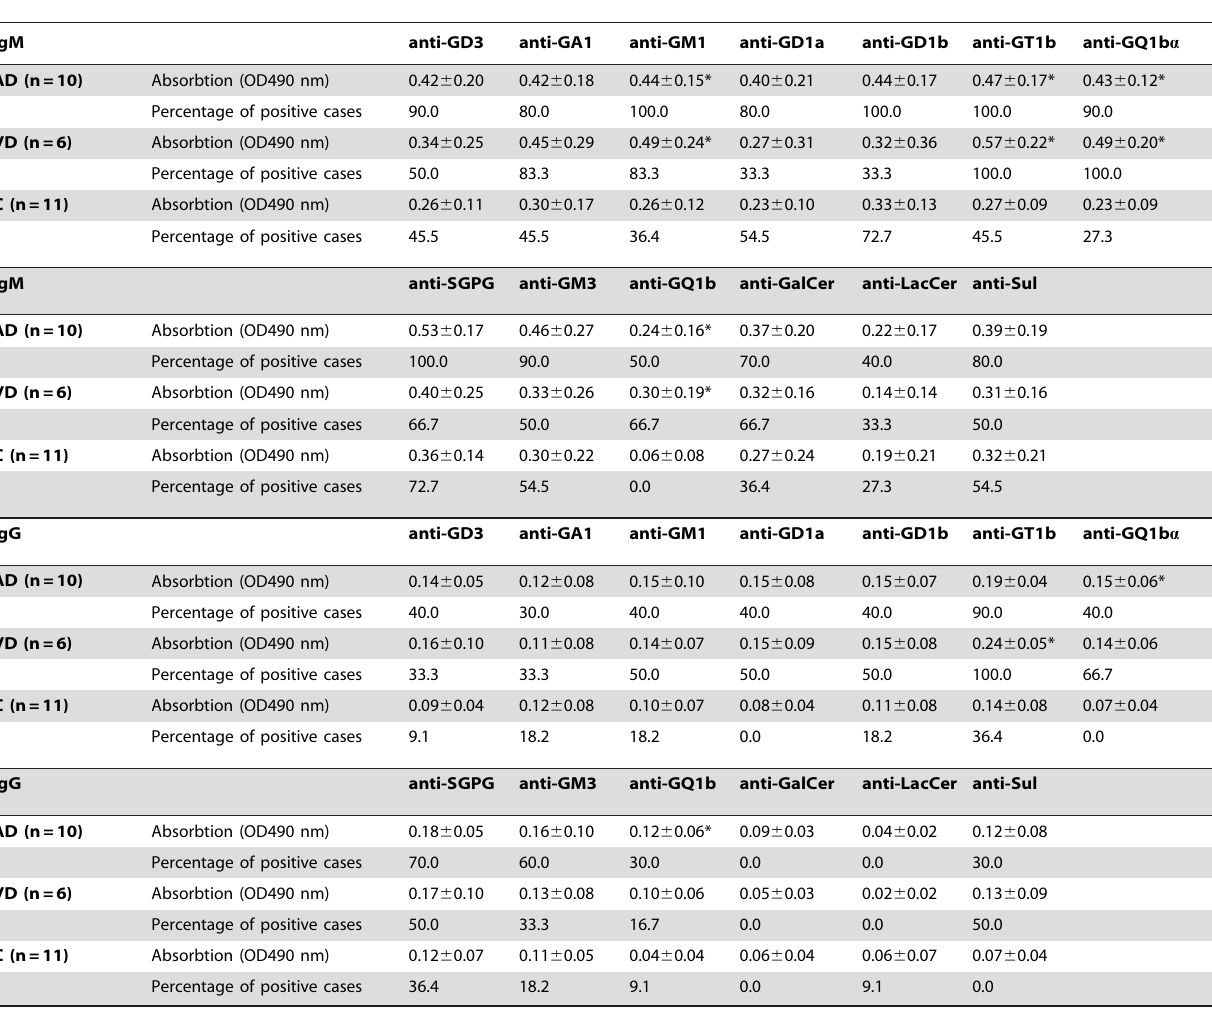
Table 2. Absorption and percentages of positive cases of anti-glycosphingolipid